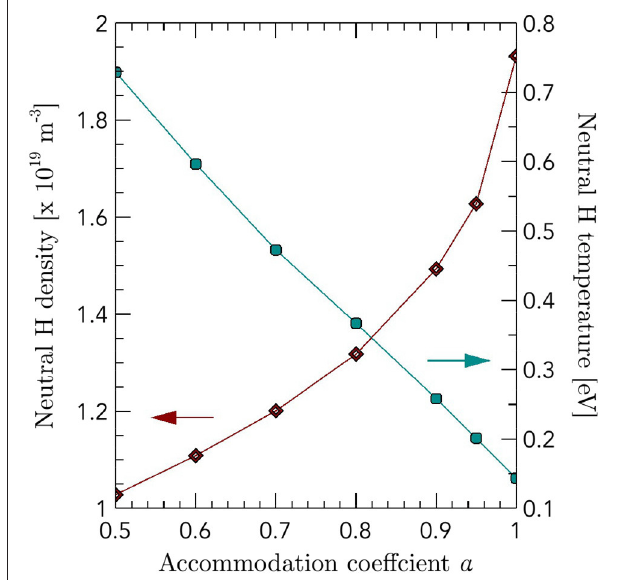
FIGURE 5 | Influence of the thermal accommodation coefficient α on the neutral hydrogen density and temperature in the BATMAN source. See Fubiani et al. [ 18] for details about the numerical